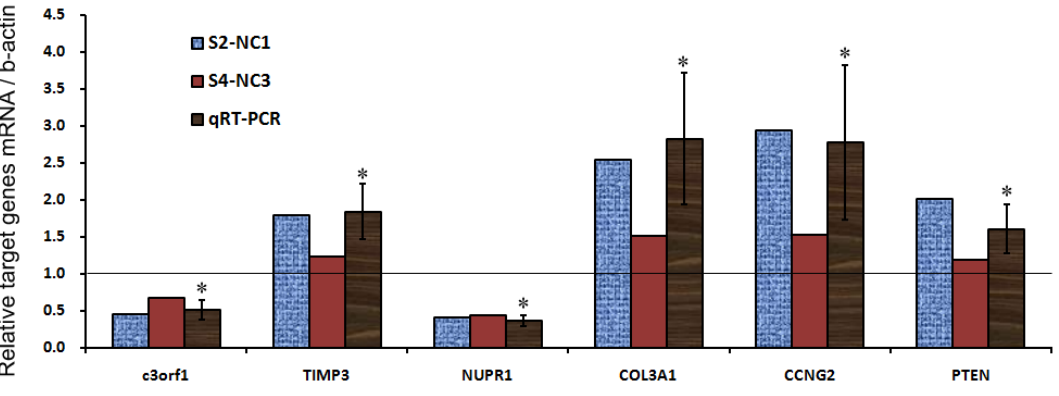
Figure 4. Alteration in the gene expression profile of C3orf1-depleted cells. Graphic representation of real-time PCR results depicting the expression of selected genes; * p <